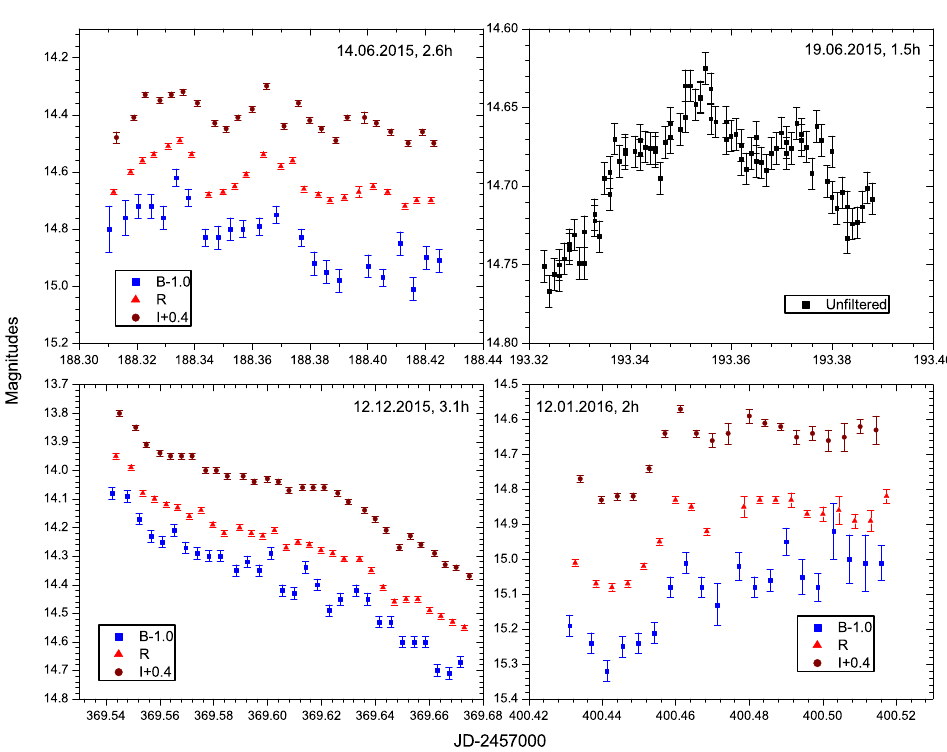
Figure 4. Examples of rapid intra-night